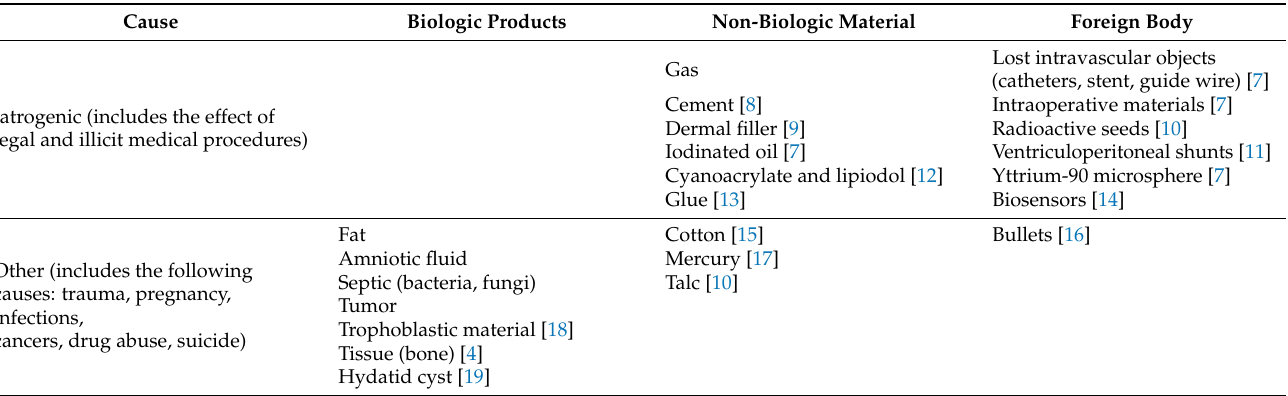
Table 1. Etiology of nontrombotic pulmonary